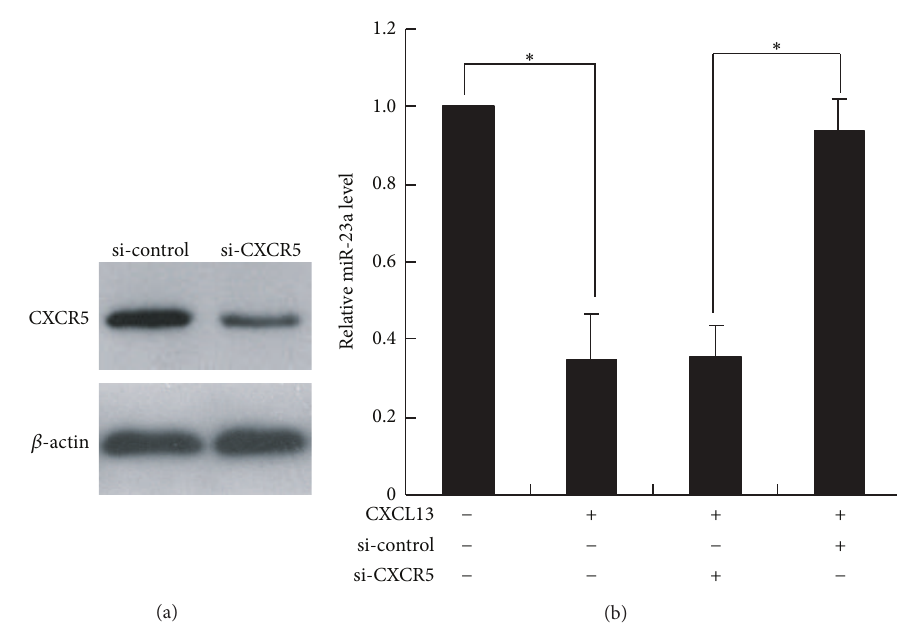
Figure 5: CXCR5 interference abrogated CXCL13-induced downregulation expression of miR-23a. Before exposure to CXCL13, cells were transfected with si-CXCR5. (a) CXCR5 expression by western blotting. (b) Analysis of expression of miR-23a. All values represent means ± SD. ∗ 𝑃 < 0.05 compared with corresponding